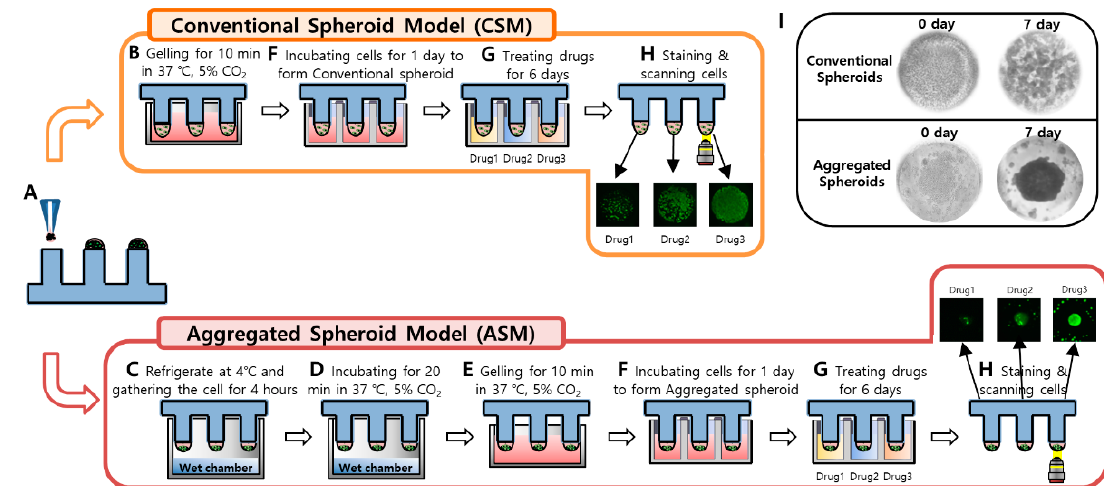
Figure 7. Experimental procedures of 3D Cell culture model implementation (CSM and ASM) using a 96-pillar/well plate. ( A ) Cell and Matrigel mixture dispensed on the surface of the 96-pillar plate. ( B ) 3D cell and Matrigel mixture directly gelling after dispensing step. ( C ) Cell down and aggregate in the core of Matrigel at 4 °C before gelling the Matrigel ( D ) 3D cell and Matrigel gelation step with the pillar surface facing downward. ( E ) Additional gelling step for 10 min. ( F ) One-day incubation for stabilizing the cells by stamping the 96-pillar plate into the 96-well plate filled with cell culture medium. ( G ) Drug exposure by replacing the 96-well plate with another filled with six different drugs. ( H ) Green fluorescence image scanning after 3D live-cell staining. ( I ) Representative images for spread 3D cells in the CSM and aggregated 3D cells in the ASM.